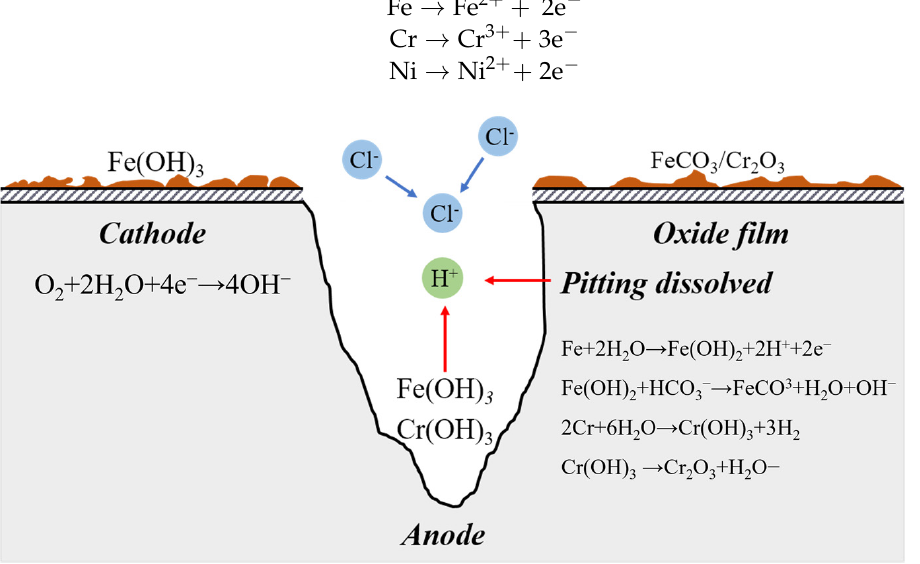
Figure 13. Electrochemical Process of Pitting